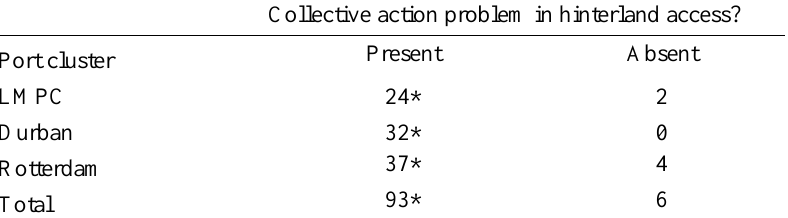
Table 4. Answers to the question ‘indicate whether or not the collective action problem is present in the case of hinterland access’?